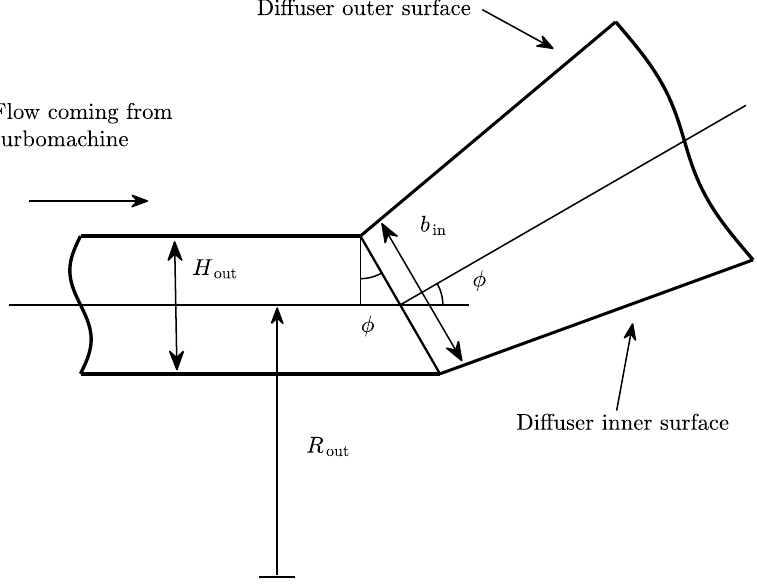
Figure 5. Connection of the diffuser model with a generic turbomachine